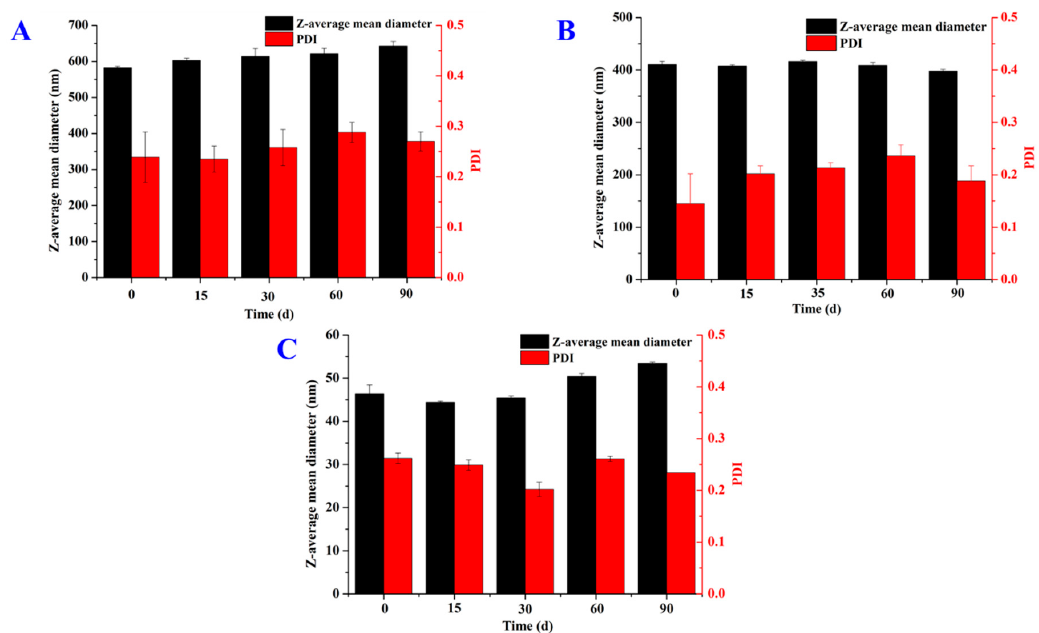
Figure 8. Changes of Z-average mean diameter and PDI of ( A ) GMS SLN dispersions with thymol loaded at 4% mass of lipids, ( B ) 1,3-LP SLN dispersions with thymol loaded at 16% mass of lipids, ( C ) PPP SLN dispersions with thymol loaded at 12% mass of lipids during 90-day storage at 25 °C. Error bars are SD ( n = 3).